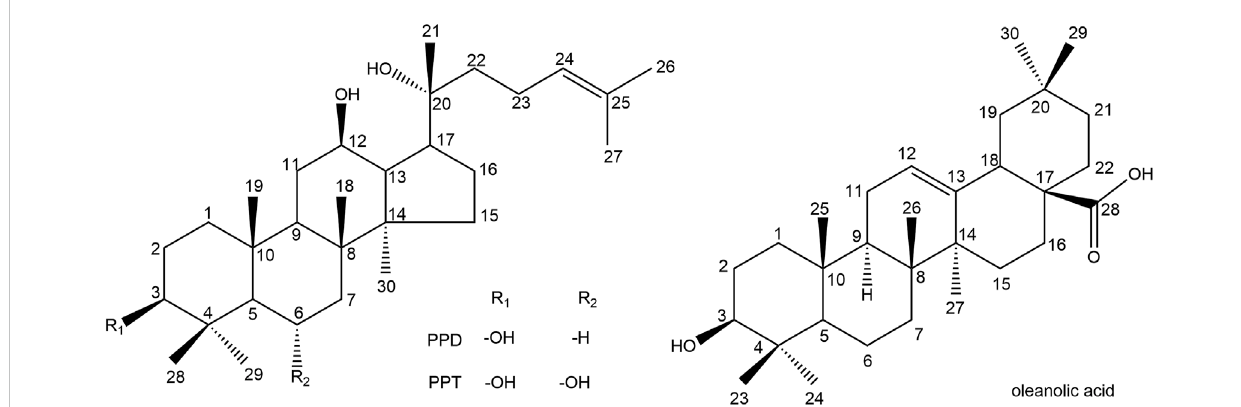
FIGURE 2 Structure of protopanaxadiol (PPD), protopanaxatriol (PPT), and oleanolic acid (OA).